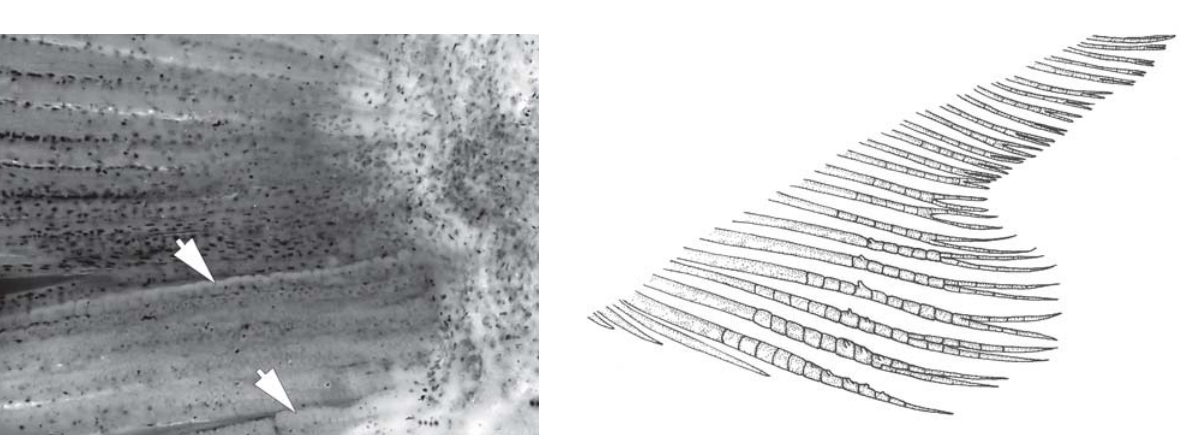
Fig. 6. Lophiobrycon weitzmani , paratype, adult male, LIRP 4338, 33.1 mm SL; anal-fin rays with hooks, lateral view, left